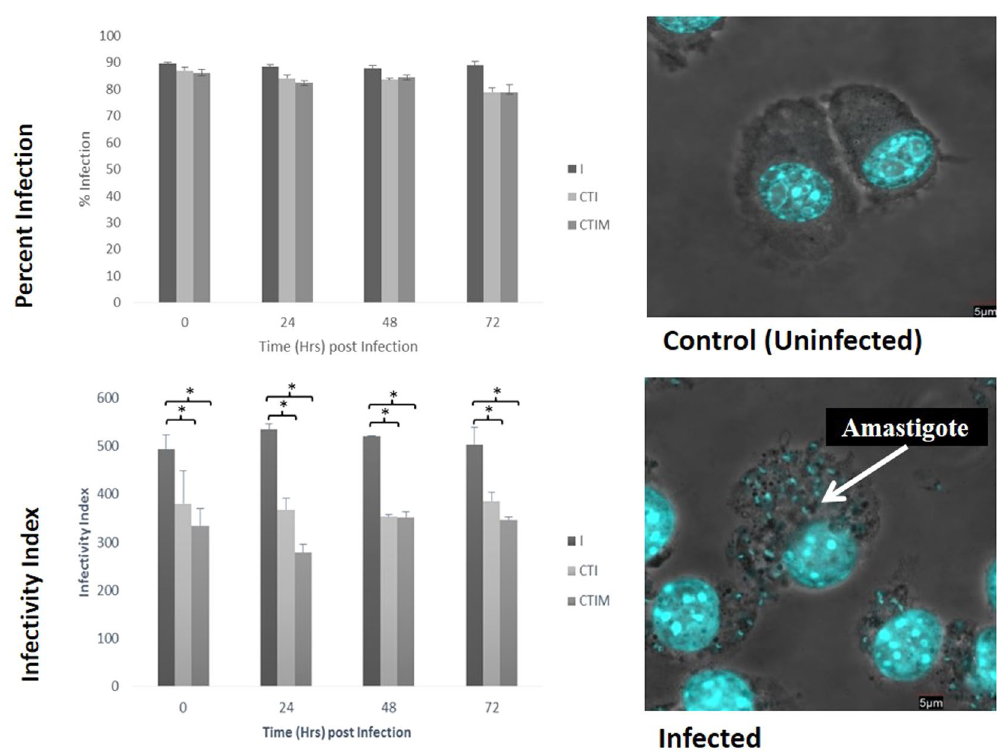
Figure 7. The percent infection and infectivity index of Leishmania infected macrophages. The lower panel shows representative figure of uninfected and infected peritoneal